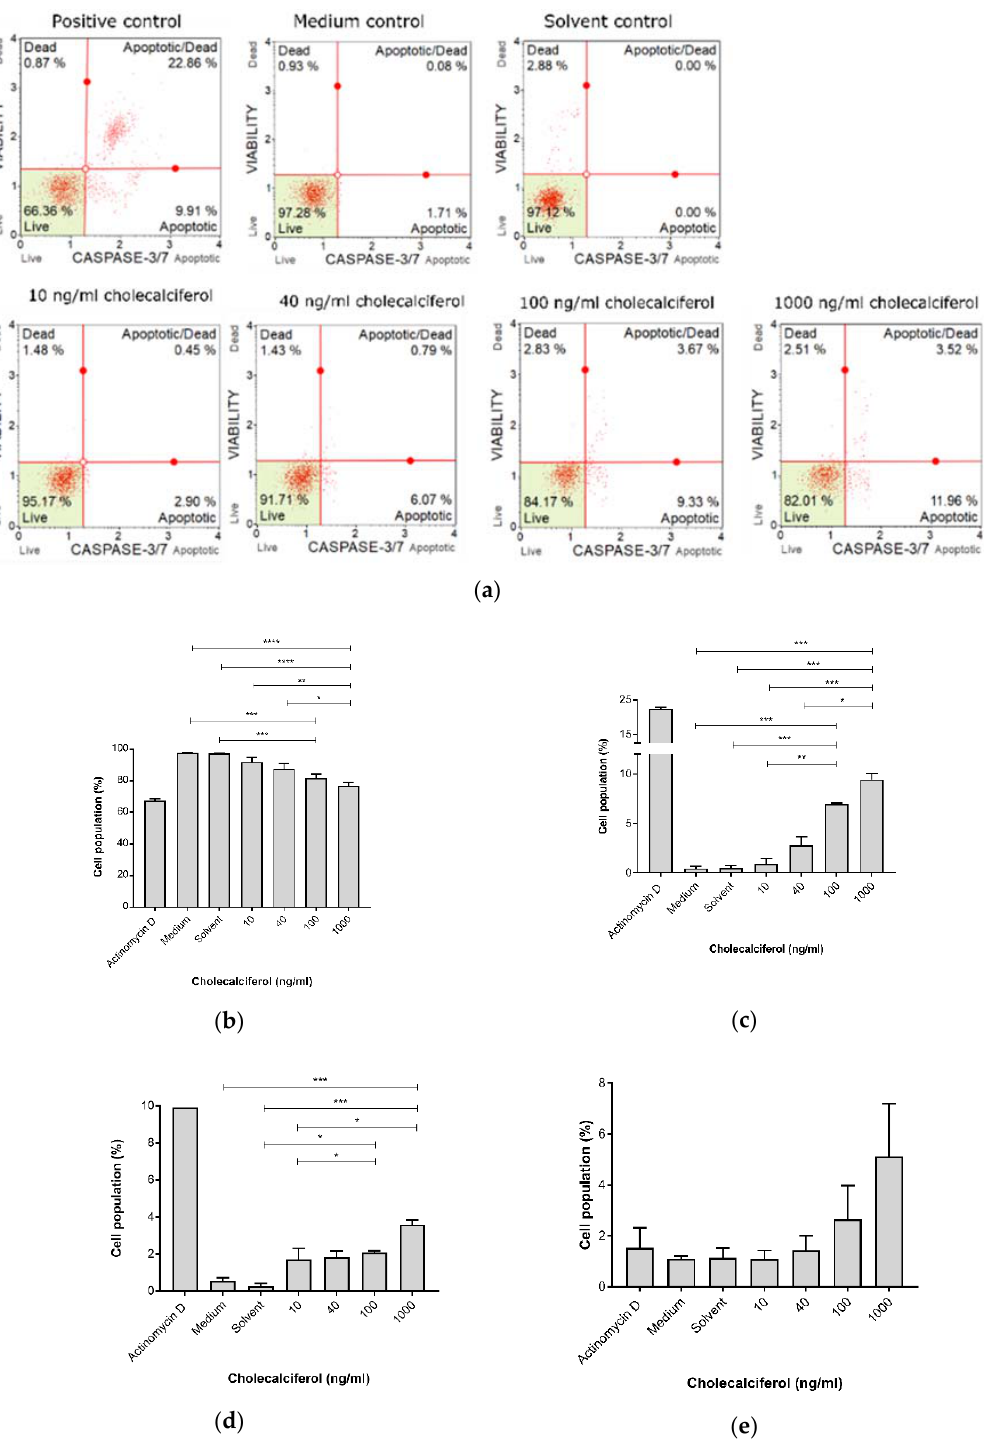
Figure 5. Caspase ‐ 3 and caspase ‐ 7 activation, measured by the Muse™ Caspase 3/7 detection kit. ( a ) Two ‐ dimensional dot ‐ plot diagrams. ( b ) Live cells, ( c ) cells undergoing apoptosis, ( d ) cells in late apoptosis, and ( e ) dead cells. Cholecalciferol significantly decreased the live cell population and late apoptotic cells at 1000 ng/mL in comparison to the low ‐ dose treatments and control cultures. Assays were performed on three biological replicates, and each replicate was technically triplicated. Values are expressed as mean ± SEM ( p < 0.05 was considered statistically significant). * p < 0.05; ** p < 0.01; *** p < 0.001; **** p <